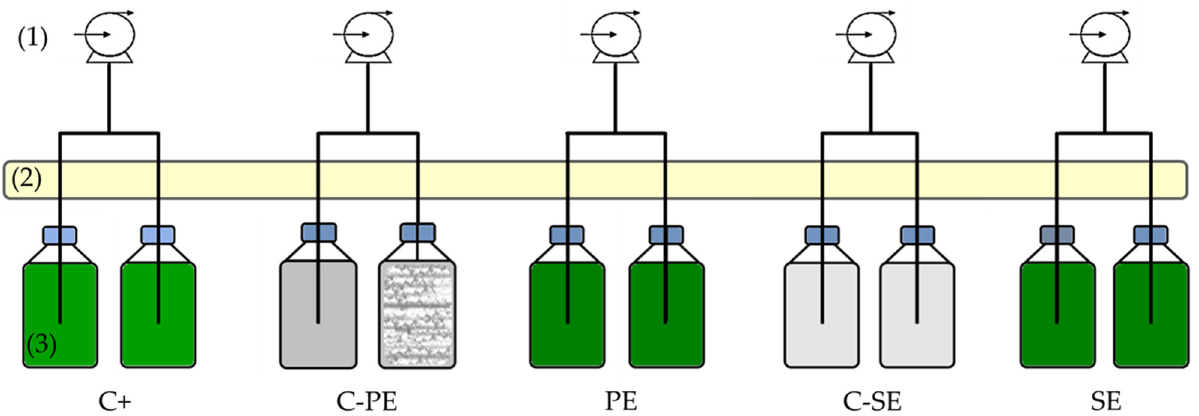
Figure 2. Schematic representation of the experimental setup: ( 1 ) air pumps to provide atmospheric air and agitation to the cultures; ( 2 ) LED panel; ( 3 ) culture bottles.